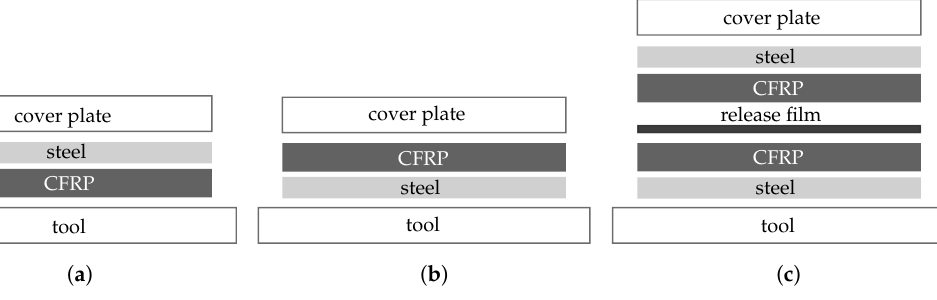
Figure 3. Different manufacturing setups regarding the placement of the layer stack between tool and cover plate. ( a ) Single setup: CFRP on tool; ( b ) Single setup: steel on tool; ( c ) Stacked